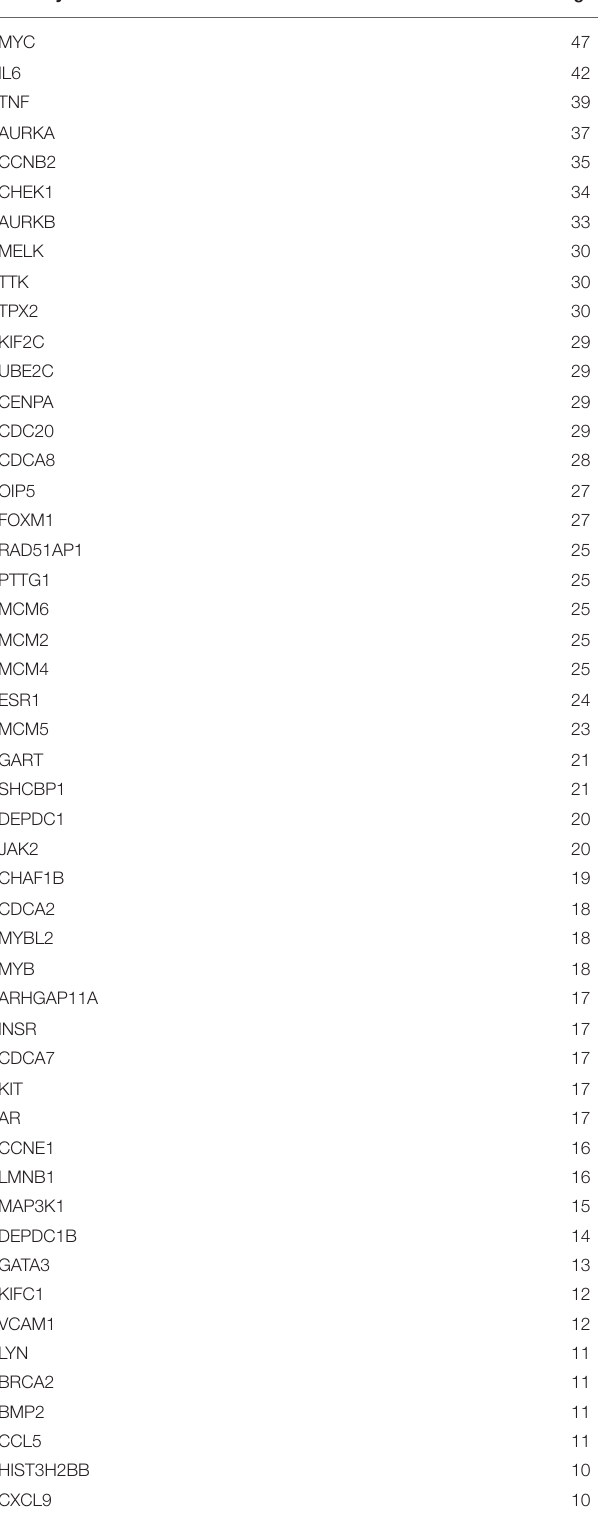
TABLE 2 | The hub genes in the protein-protein interaction (PPI) network (Degree ≥ 10). Gene symbol